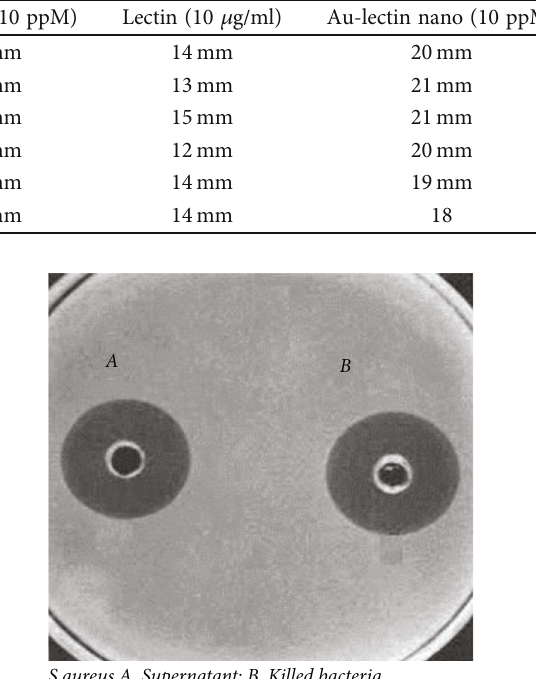
Figure 5: The diameter of inhibition zone for S. aureus . Zone of inhibition against tested pathogen suggests that nanoparticle- treated-killed bacteria are reservoirs of these